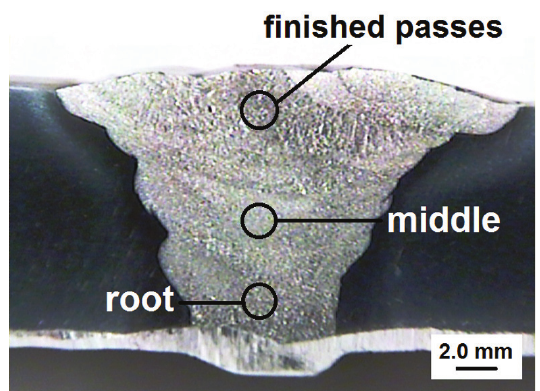
Figure 1. Macrostructure of the weld